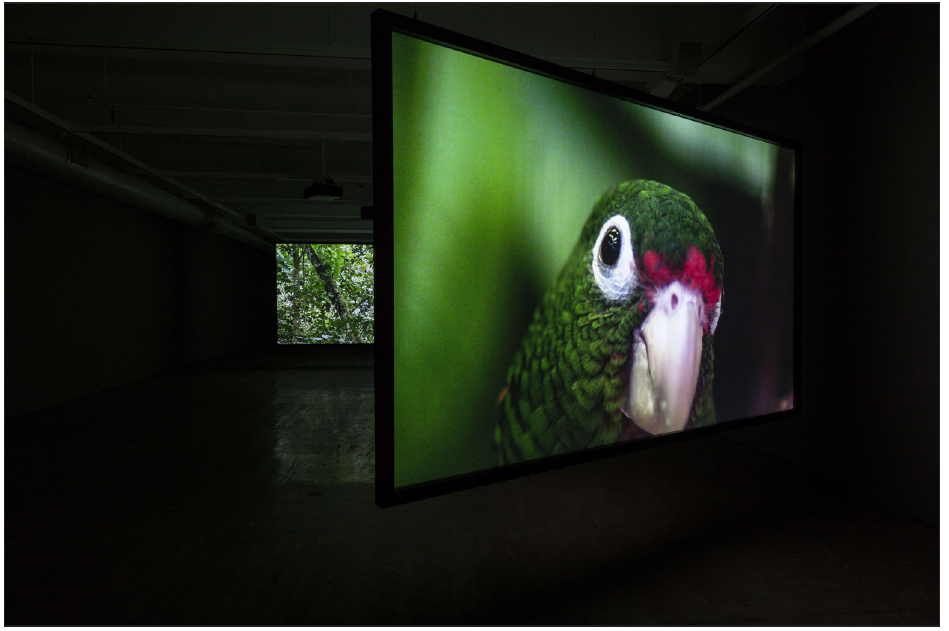
Figure 2: Allora & Calzadilla, The Great Silence, 2014, © the artists, courtesy Lisson Gallery: Allora & Calzadilla, The Great Silence, 2014, © the artists, courtesy Lisson